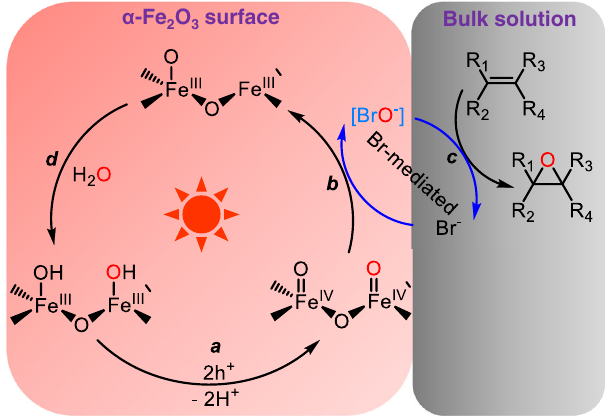
Fig. 4 | Schematic illustrations for epoxidation of alkenes by a Br − /BrO − -medi- ated pathway. In the process of Br-mediation epoxidation, the BrO − species are generated via an OAT pathway from Fe IV =O species on the surface of α -Fe 2 O 3 , and then transfer the oxygen atom to the alkene in the bulk